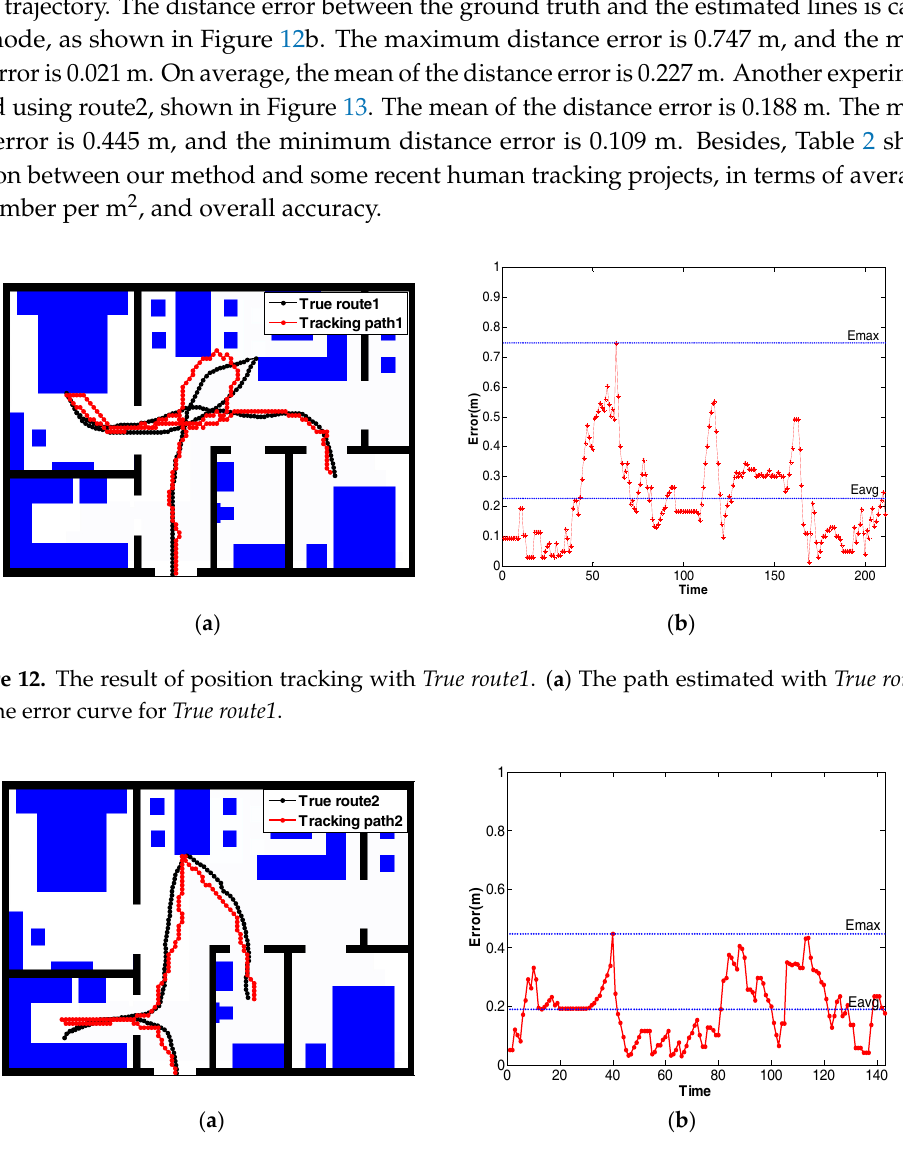
Figure 13. The result of position tracking with True route2 . ( a ) The path estimated with True route2 ; ( b ) The error curve for True route2 . Table 2. Recent project of human tracking.